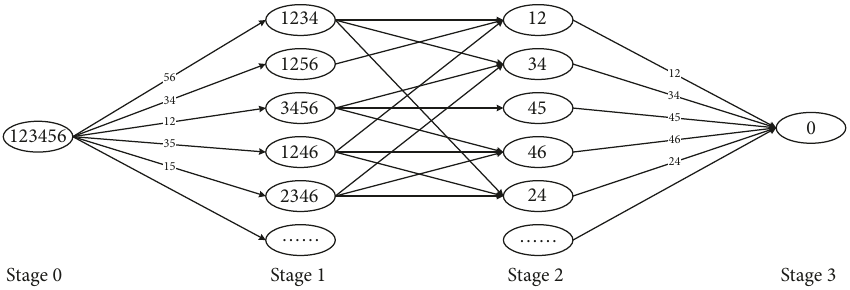
Figure 1: A directed acyclic graph of the three-stage maintenance